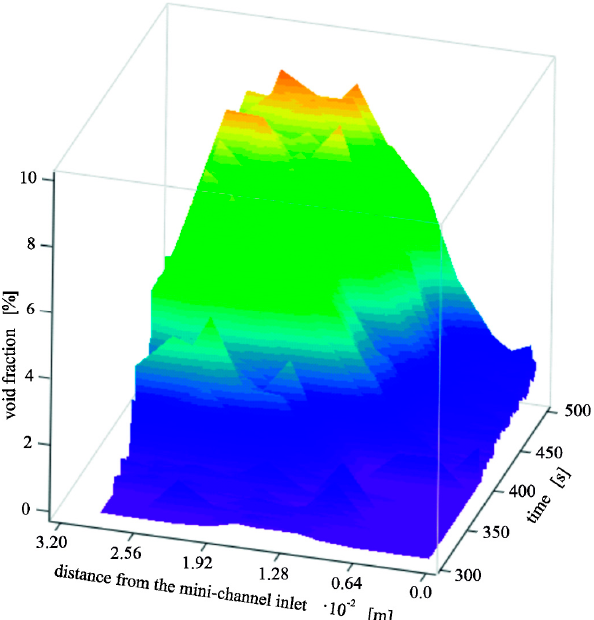
Figure 5. Void fraction versus time and distance from the mini-channel inlet; experimental param- eters are listed in Table 1.